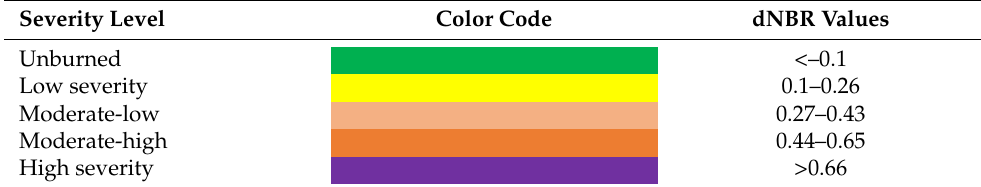
Table 1. Severity levels and the differenced normalized burn ratio (dNBR)